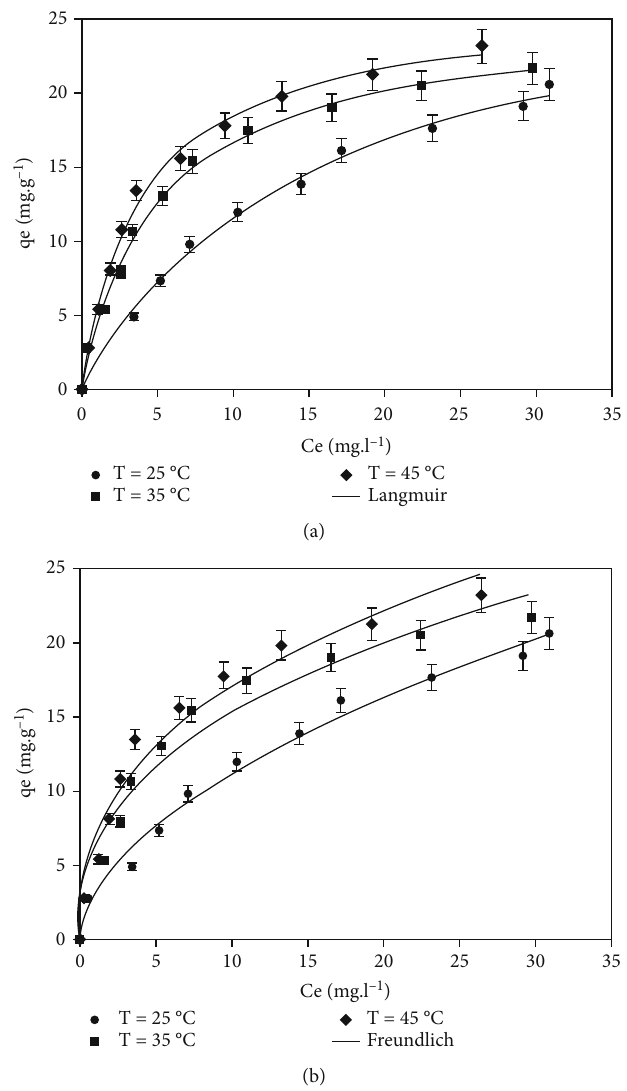
Figure 6: (a) Langmuir and (b) Freundlich isotherm curves at the values for best